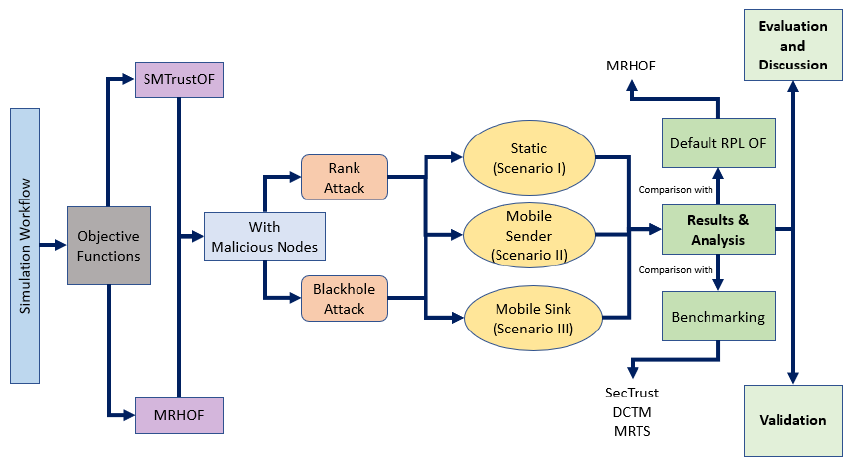
Figure 5. Simulation workflow.